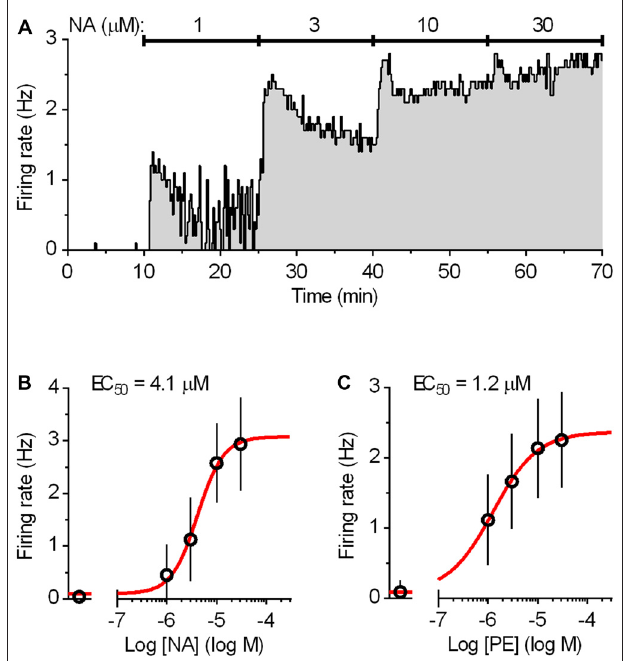
FIGURE 2 | Dose-response curves for the activation of the DRN serotonergic neurons by noradrenaline (NA) and phenylephrine (PE). (A) Integrated firing rate histogram (10 s bins) showing the effect of bath application of NA on the firing rate of a DRN serotonergic neuron. Increasing concentrations of NA (15 min each) were applied during the times indicated by solid lines. The firing rate during the last 3 min at each concentration was used for construction of the dose-response curve. (B) Average dose-response curve for NA. Symbols represent the mean of eight experiments. Error bars represent SD. Curve (red) represents the best least squares fit to four-parameter logistic equation. (C) Average dose-response curve for α 1-adrenergic receptor agonist PE constructed in the same way as that of NA. Symbols represent the mean of nine experiments. Error bars represent SD. Curve (red) represents the best least squares fit to four-parameter logistic